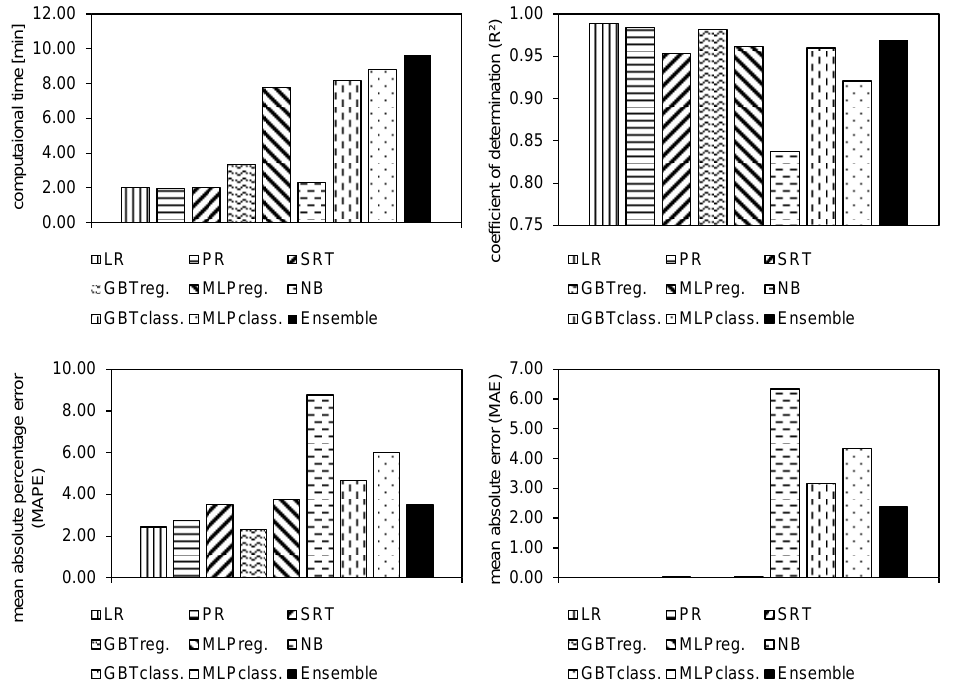
Figure A2. Summary of data mining results predicting the electric power demand.